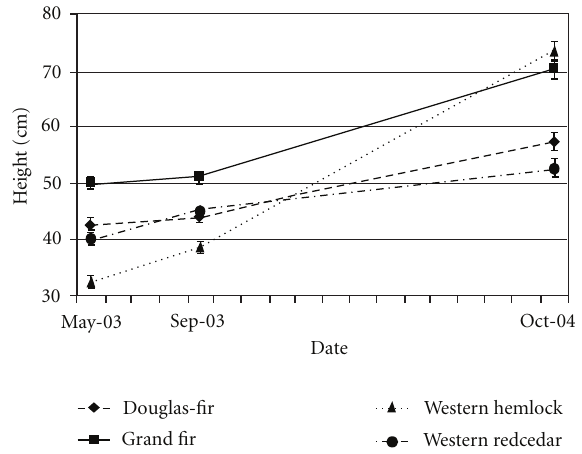
Figure 3: Height growth of four conifer species planted in contigu- ous plots. Bars represent one standard error of the